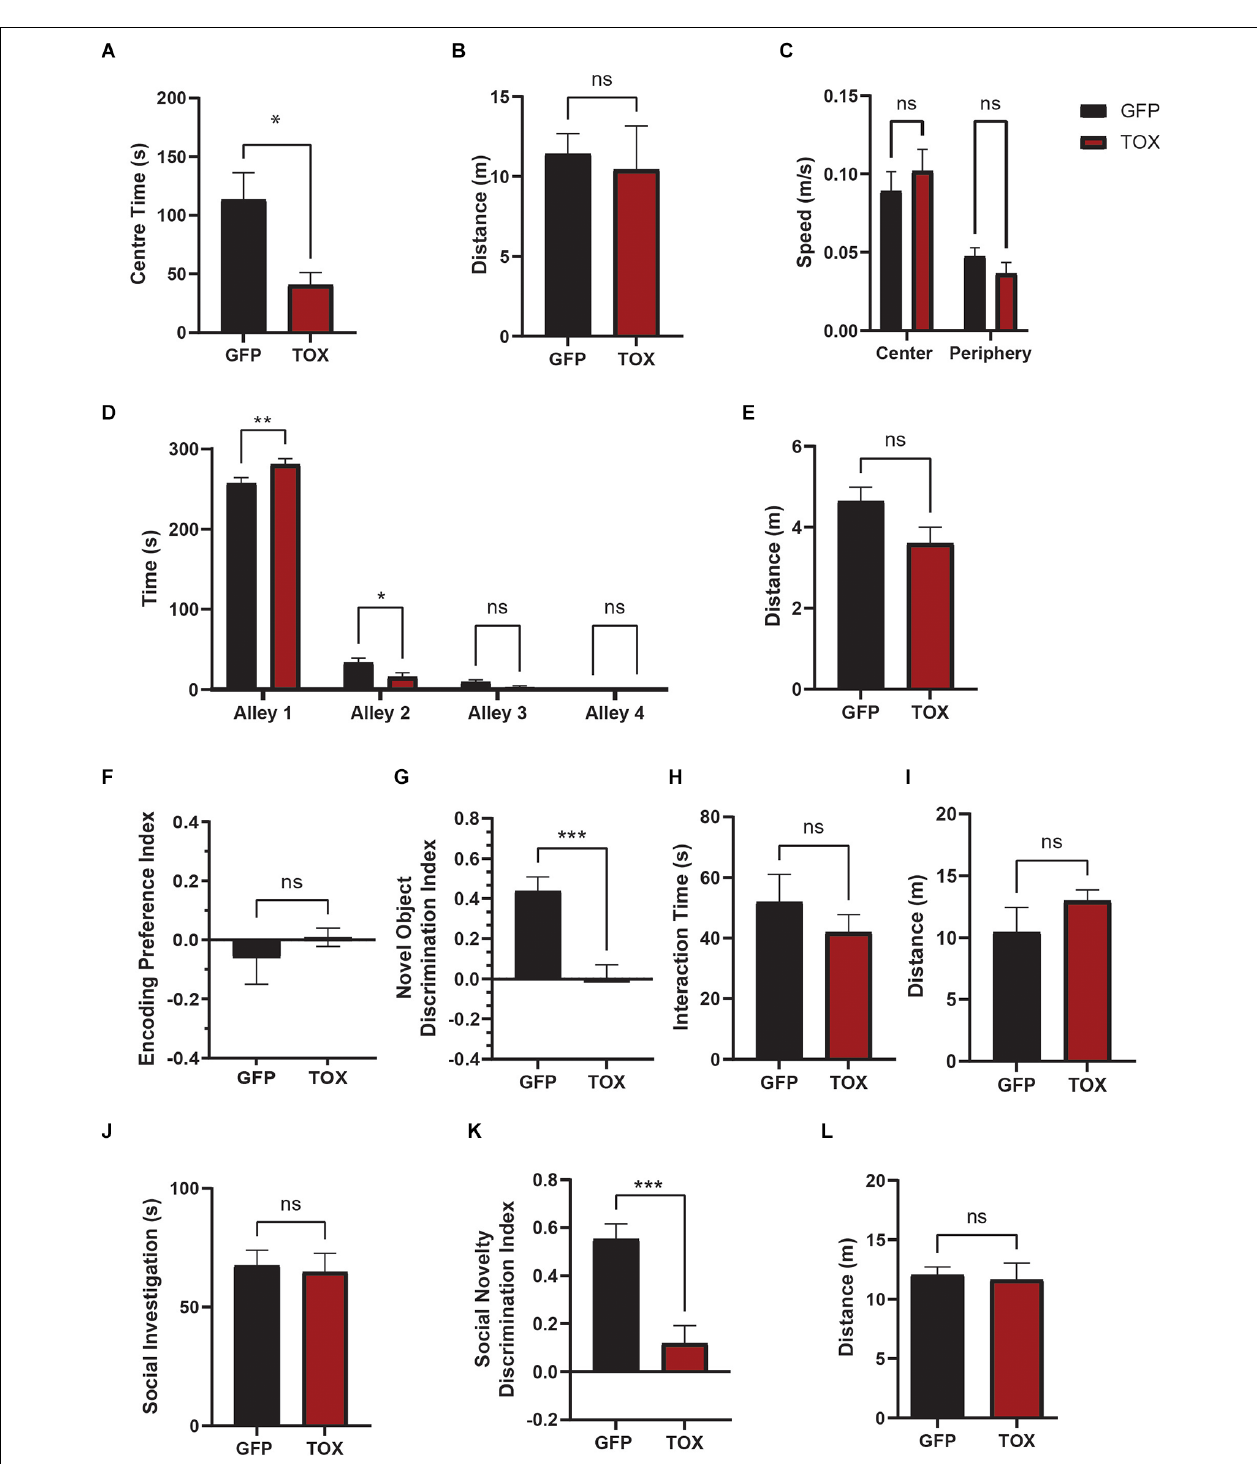
FIGURE 5 | AHN GABA synaptic silencing results to abnormalities in anxiety behavior and cognitive impairments, affective and cognitive functions. (A) TOX mice are more anxious and avoid center area of the open field (OF) (GFP N = 13, TOX N = 10, unpaired t -test, t = 2.595, df = 21, * p = 0.0169). (B) Total distance traveled in open field did not differ between TOX and GFP (unpaired t -test, t = 0.3521, df = 21, p = 0.7283, NS). (C) Mean speed (m/s) of centerand periphery zone did not differ between TOX and GFP (2-WAY ANOVA, Zone × AHN treatment, F (1,42) = 1.337, p = 0.2541, NS, zone effect, F (1,42) = 26.97, ∗∗∗∗ p < 0.0001, AHN treatment effect, F (1,42) = 0.007982, p = 0.9292, NS, Bonferroni’s multiple comparisons test, CenterTOX vs. GFP, p = 0.7669, NS, Periphery ArchT vs. GFP, p = 0.9096, NS).